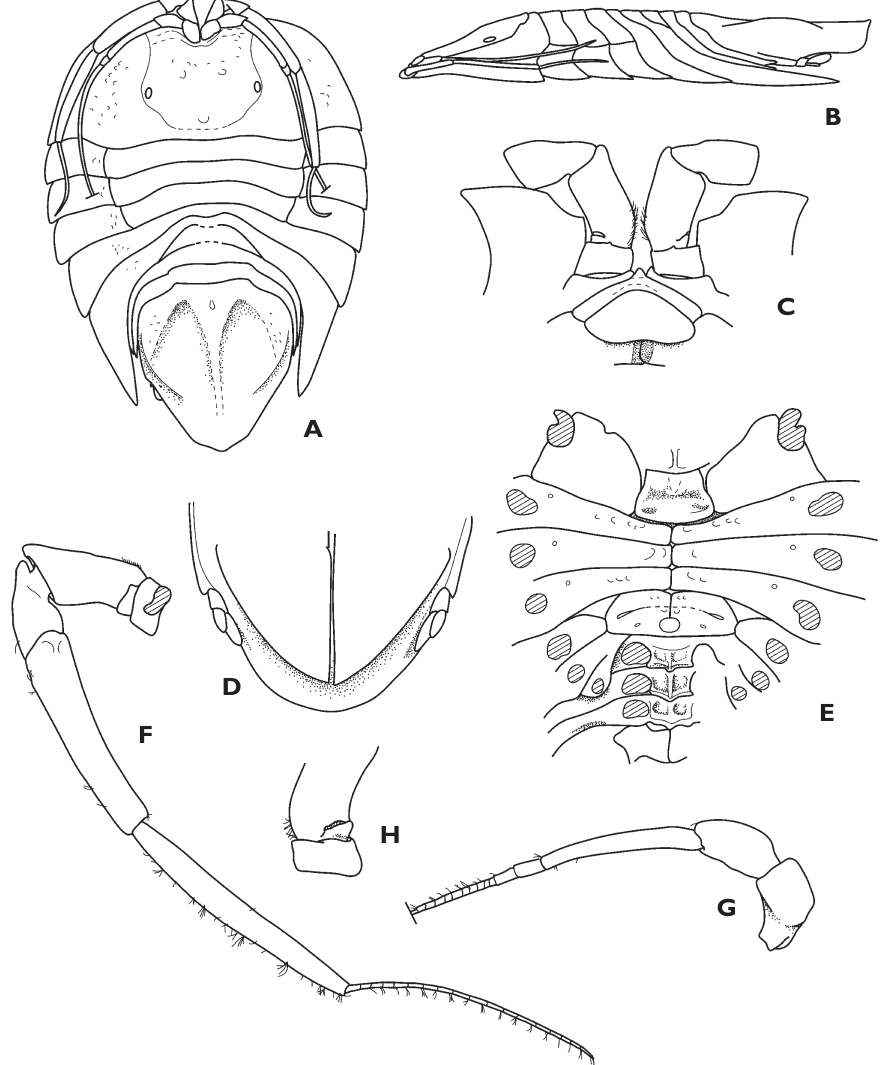
Figure 9. Myopiarolis koro sp. n. Holotype, except F–H, female paratype. A dorsal view B lateral view C frons D pleon and pleotelson, ventral view E sternites and ventral pleonites F antenna G antennule H antenna article 2, ventral